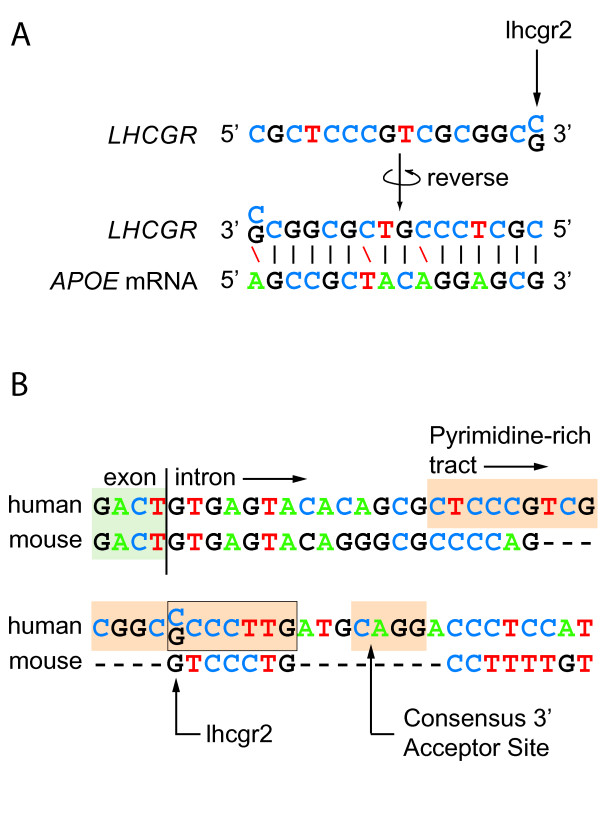
lhcgr2 shares similarity with consensus 3' acceptor splice sites and ApoE mRNA. (A) lhcgr2 as a potential miRNA that regulates the expression of ApoE. The reversed LHCGR sequence is complimentary to a fragment of APOE mRNA at 13 out of 16 sites. (B) Pairwise sequence alignment of a portion of LHR intron 1 in human and mouse (Mus musculus). The human sequence includes lhr2 (rs4073366) and bears sequence features characteristic of 3' acceptor splice sites.